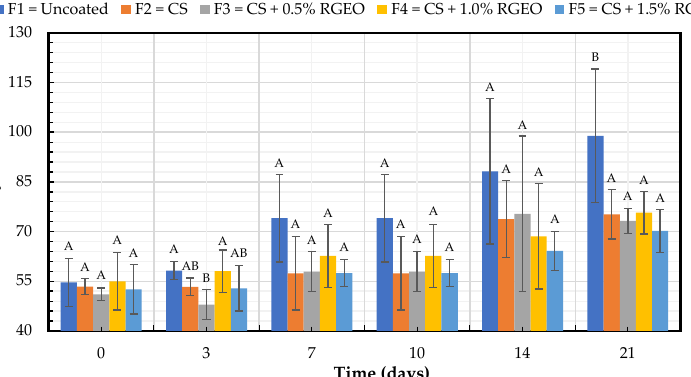
Figure 4. Maturity index of pears during the storage time with CS + RGEO treatments: F1 = uncoated, F2 = CS, F3 = CS + RGEO 0.5%, F4 = CS + RGEO 1.0%, and F5 = CS + RGEO 1.5%. According to the ANOVA test, mean values and intervals of Duncan test for treatments and Fisher for days with 95%. Different lowercase letters (a, b, c) indicate significant differ ‐ ences between days according to the LSD Fisher test for each treatment in a confidence interval of 95%. In contrast, differ ‐ ent uppercase letters (A, B, C) indicate significant differences between treatments for each day according to the Duncan test in a confidence interval of 95%.